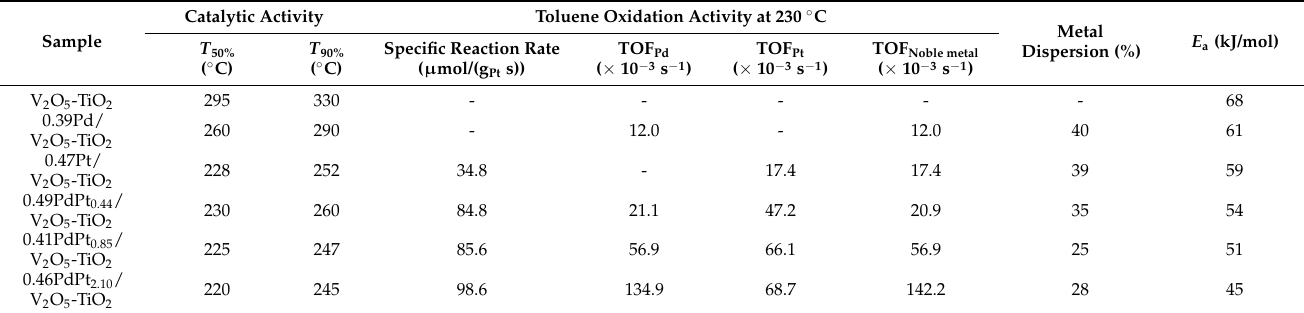
Figure 3. ( A ) Toluene conversion as a function of temperature and ( B ) ln k versus inverse temperature for (a) 0.46PdPt 2.10 /V 2 O 5 -TiO 2 , (b) 0.41PdPt 0.85 /V 2 O 5 -TiO 2 , (c) 0.49PdPt 0.44 /V 2 O 5 - TiO 2 , (d) 0.47Pt/V 2 O 5 -TiO 2 , (e) 0.39Pd/V 2 O 5 -TiO 2 , and (f) V 2 O 5 -TiO 2 for toluene oxidation at SV = 40,000 mL/(g h). Table 2. Catalytic activities; specific reaction rates at 230 ◦ C; TOF Pd , TOF Pt , and TOF Noble metal at 230 ◦ C; metal dispersion; and apparent activation energies ( E a ) of the samples for toluene oxidation at SV = 40,000 mL/(g